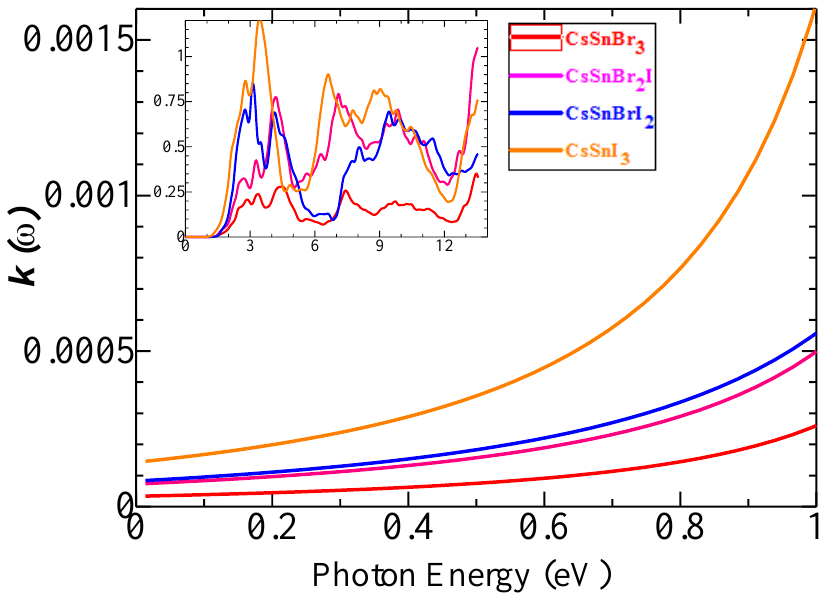
Figure 2. The calculated value of k(ω) for CsSnBr 3 , CsSnIBr 2 , CsSnI 2 Br and CsSnI 3 depending on the photon energy (inset: extinction coefficient ranging from 0 to 14 eV)